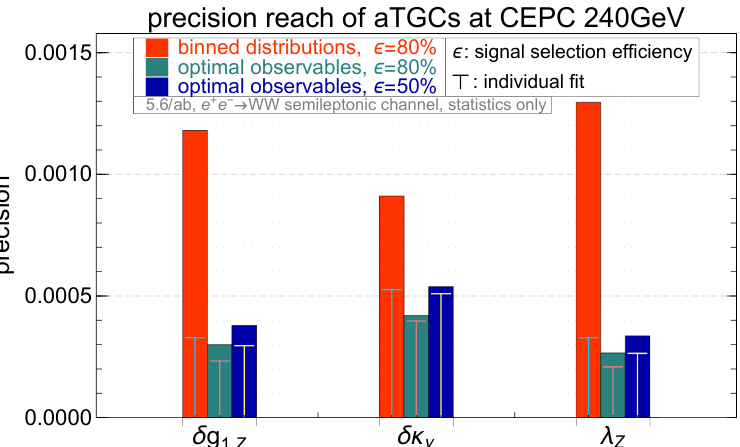
Figure 13 . A comparison of the reach on aTGCs from the binned method used in ref. [67] and the optimal observables for the diboson measurement at CEPC 240 GeV. To match ref. [67], we use both the total rate and the normalized distributions of the semileptonic channel, and impose the TGC dominance assumption. A 80% signal selection e(cid:14)ciency is assumed in ref.